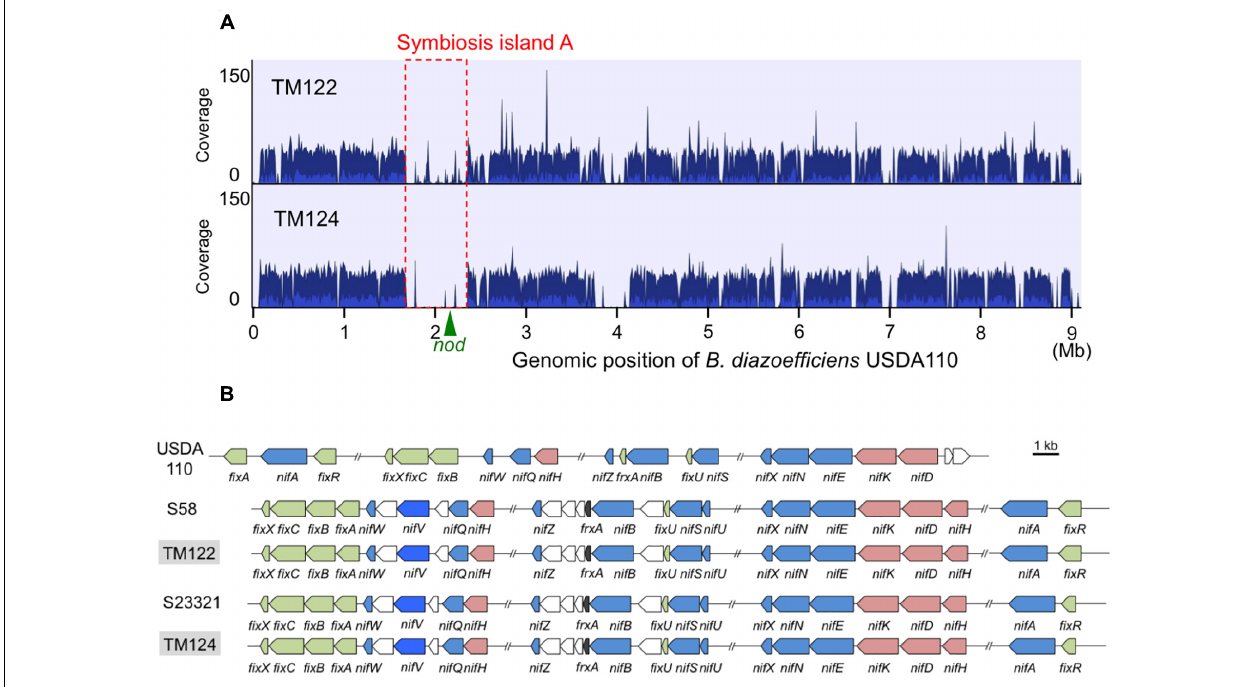
FIGURE 5 | Genomic comparison between sorghum root isolates of TM122 and TM124 and phylogenetically close bradyrhizobia. (A) Mapping of MiSeq reads of TM122 (1,191,548 reads of 213 bp in average length) and TM124 (1,190,703 reads of 208 bp in average length) on B. diazoefficiens USDA110 T genome with symbiosis island (Kaneko et al., 2002). The coverage within symbiosis island (red dotted lines) including nod genes (Kaneko et al., 2002, 2011) were apparently lower than those of other genomic regions. Cluster of nif genes of USDA110 T is located on symbiosis island (Kaneko et al., 2002). (B) The organization of nif genes of TM122 and TM124 (light gray) compared to those of B. diazoefficiens USDA110 T , B. oligotrophicum S58, and Bradyrhizobium sp. S23321. Colored pentagons indicate (pink) structural nifHDK , (blue) other nif , and (green) fix genes.